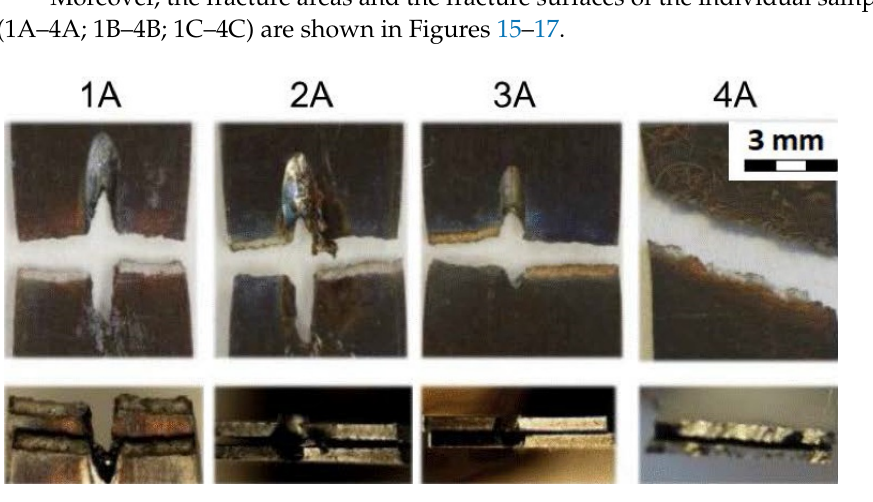
Figure 15. Fracture areas and fracture surfaces of individual sample groups—material thickness 0.5 mm; tests at elevated temperature.